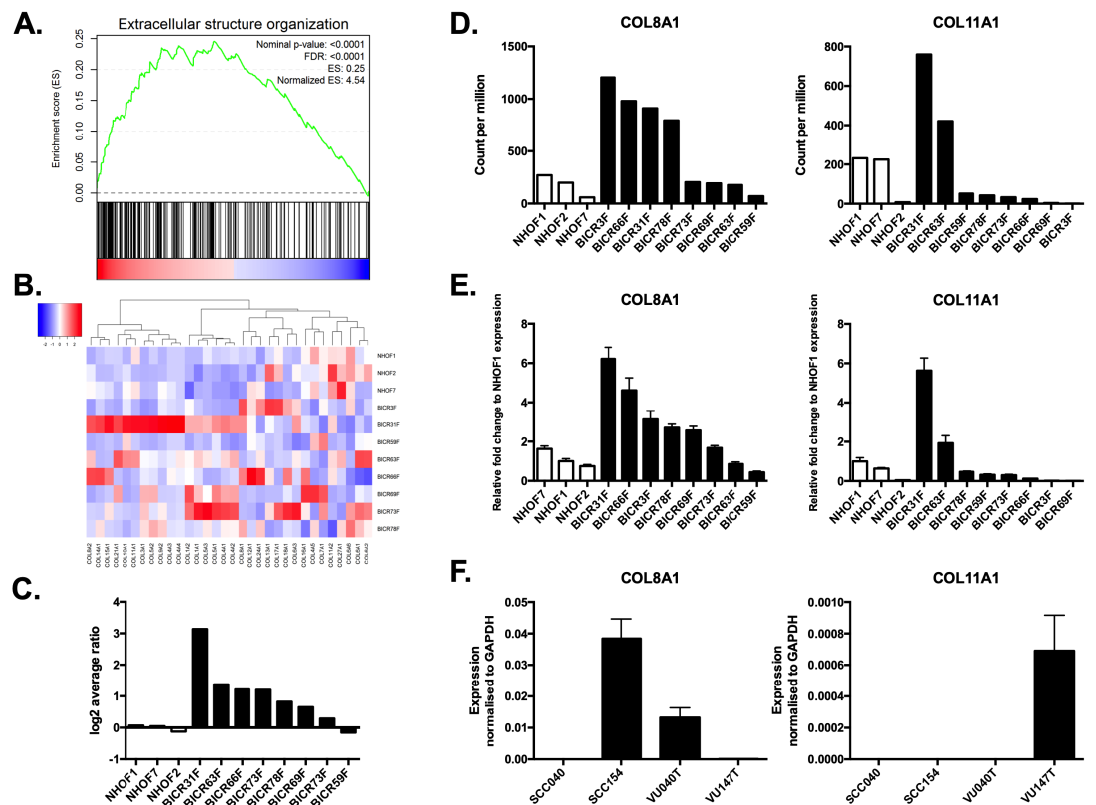
Figure 1. Collagen expression in cancer-associated fibroblasts (CAFs) and head and neck squamous cell carcinoma (HNSCC) cells. ( A ) Extracellular structure organization was the most significantly enriched gene ontology (GO) term identified by gene set enrichment analysis (GSEA) of genes differentially expressed between normal human oral fibroblasts (NHOFs) and CAFs, as determined by RNAseq. ( B ) Heatmap highlighting the elevated expression of collagen subtypes in CAFs. ( C ) Total collagen expression (average expression of all collagen subtypes from RNAseq) was higher in the majority of CAF strains compared to normal fibroblasts. ( D ) Expression of COL8A1 and COL11A1 in NHOFs and CAFs, as determined by RNAseq. ( E ) RT-qPCR was used to confirm the expression of COL8A1 and COL11A1 in fibroblast strains. ( F ) RT-qPCR analysis showed COL8A1 and COL11A1 were also expressed in some HNSCC cell lines. Data for the RT-qPCR experiments are shown as mean +/− SD values of triplicates.